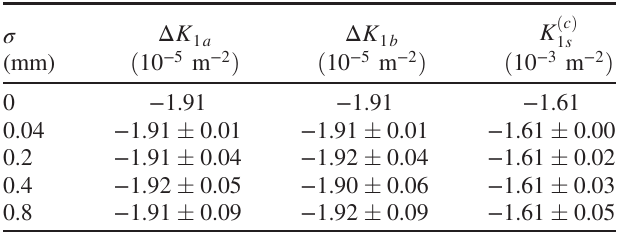
TABLE X. Corrector strengths estimated with the same TBT data sets used in Table IX but applying the analyses used to obtain Table II with average max